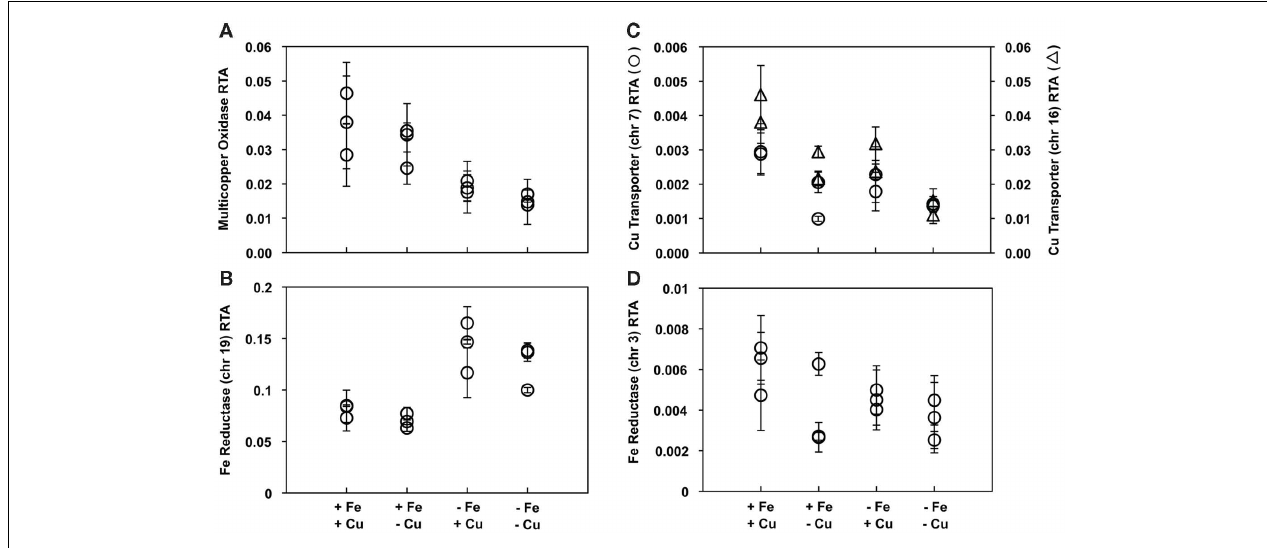
reductase located on chr 3, all normalized to expression levels of actin. Results from culture replicates are shown; each symbol within a treatment indicates a replicate. Error bars represent the SD of triplicate relative transcript abundance determinations (separate cDNA syntheses) for each culture